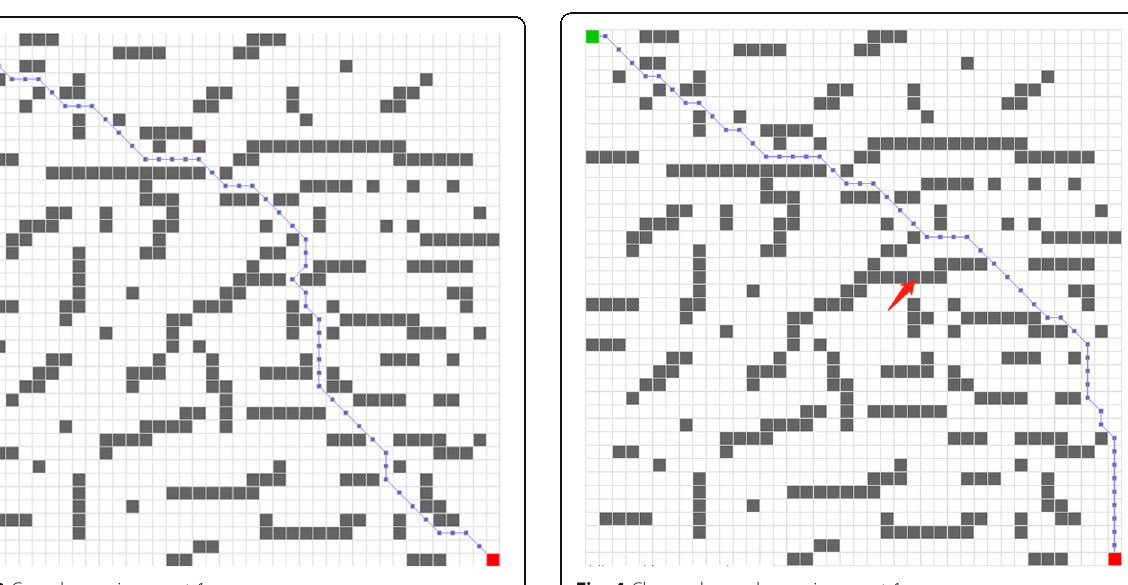
Fig. 3 Complex environment 1 Fig. 4 Changed complex environment